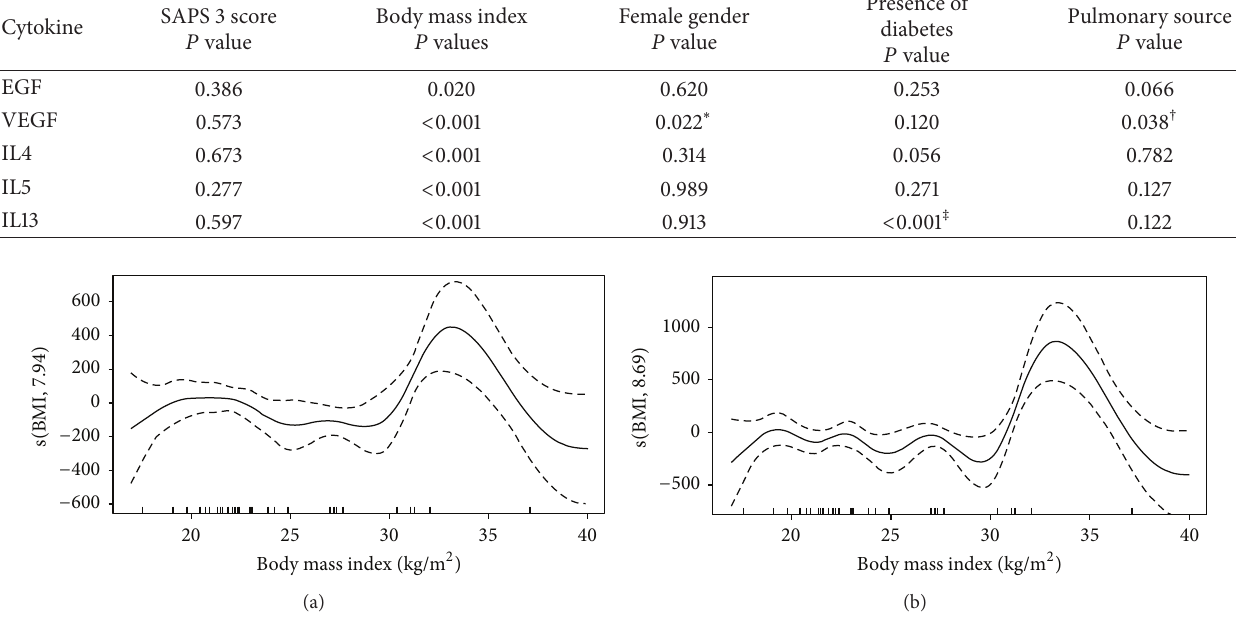
Figure 2: Association between EGF (a) and VEGF (b) and body mass index. Intervals are Bayesian credible intervals.